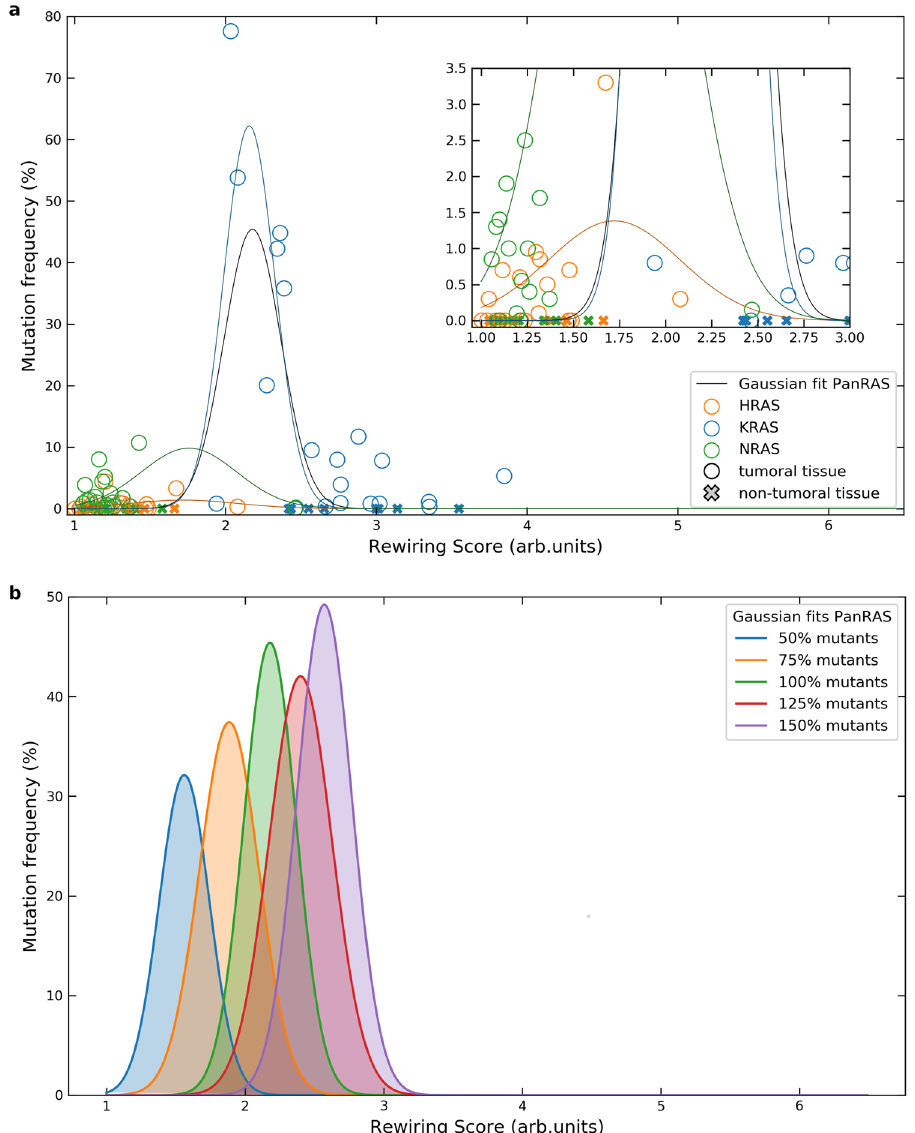
Fig. 6 Analysis of the relation between isoform-speci fi c network rewiring and mutation frequencies for different mutant levels. a Data points and fi ts are calculated for Ras isoform mutants with a 100% GTP load. Gaussian interpolations on both Ras isoform-speci fi c and PanRas- general data are traced in solid lines (respectively, blue, orange, and green, for H-, K-, and NRAS; black for all the dataset). Each fi t is performed excluding the tissues which rarely are associated with cancer (see main text); the corresponding data points are indicated with cross markers. The parameters for the Gaussian fi ts, for H-, K-, N-, and PanRAS are, respectively: mean of 1.72, 2.15, 1.76, and 2.18, and standard deviation of 0.36, 0.17, 0.32, and 0.19. b Mutation frequency vs. network rewiring score for varying level of Ras isoform mutants (from 50% to 150%). Gaussian fi ts are performed on PanRas data points. Parameters for the fi ts (from left to right) are the following – means: 1.56, 1.89, 2.18, 2.4, 2.57; standard deviations: 0.18, 0.21, 0.19, 0.22,